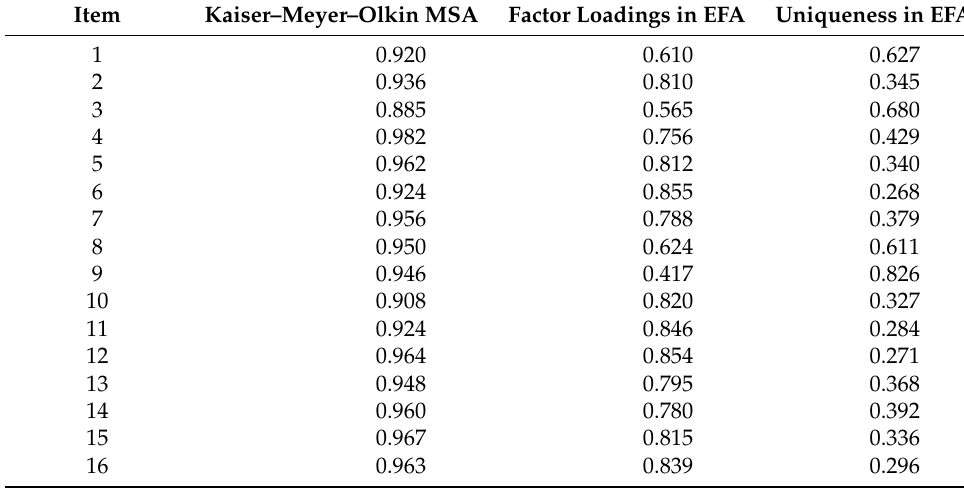
Table 1. Kaiser–Meyer–Olkin measure of sampling adequacy (MSA) for individual items of DSES, factor loadings, and uniqueness which was obtained in exploratory factor analysis performed on data from Sample 1.